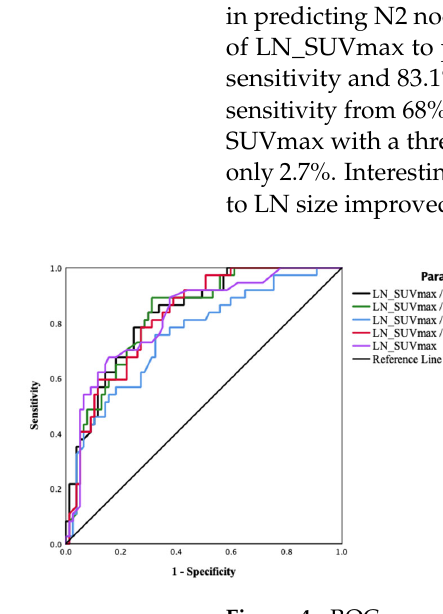
Figure 4. ROC curve analysis comparing the diagnostic performance of individual markers for mediastinal (N2) nodal involvement and normalisation of SUVmax of the lymph nodes (LN_SUVmax) to factors of interest. The left-side panel shows ROC curves comparing various normalisation methods (ratios) to LN SUVmax, and the right-side panel shows the ROC curves for the other parameters examined. Table 4. Performance at selected threshold for each parameter.